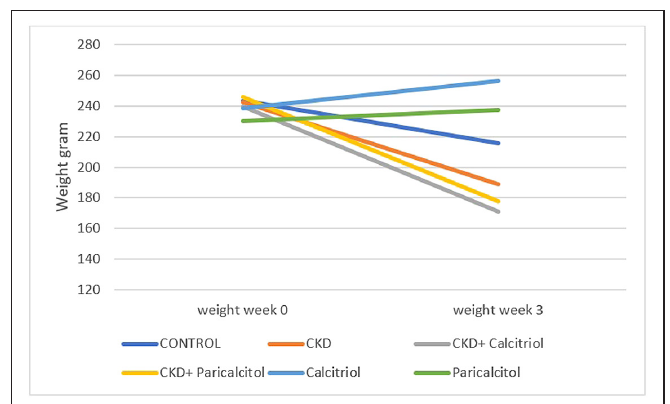
Figure 1. Change in body